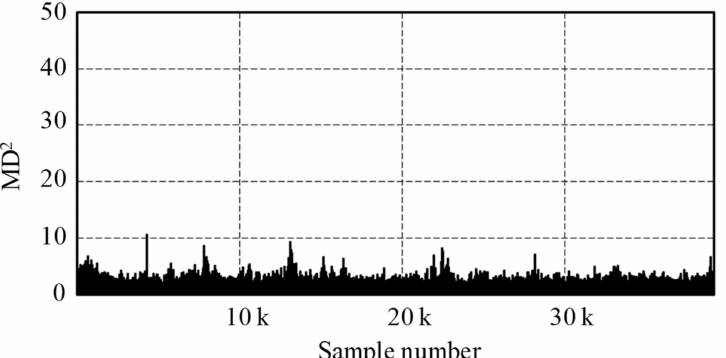
Figure 9. MD 2 calculated based on the optimal selection of the frequency band around each of the peak